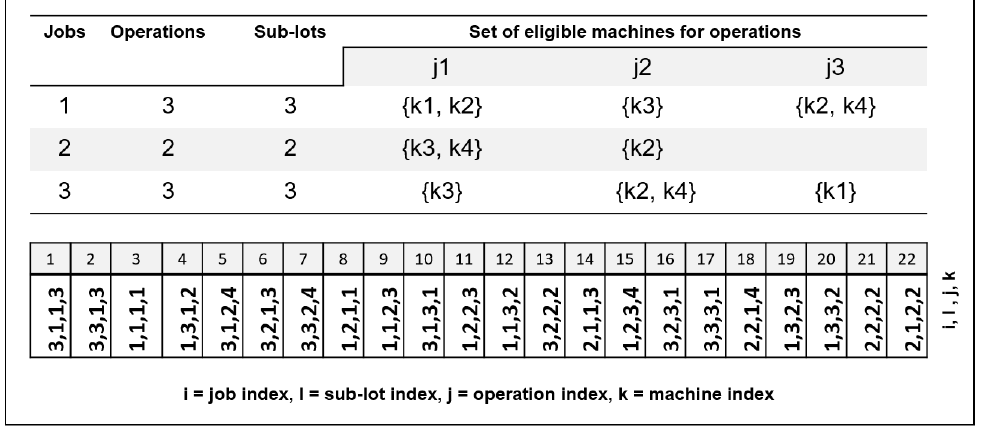
Figure 3. Representation of the assignment of operations to machines and their sequencing.